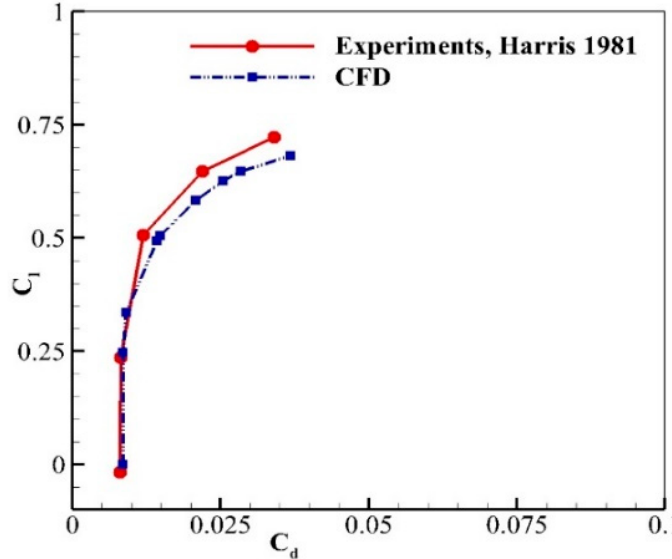
Figure 11. Variation of computed C l with the angle of attack for the NACA0012 airfoil at Mach = 0.7 and Re ∞ = 9 × 10 6 , compared with the experiments [23].